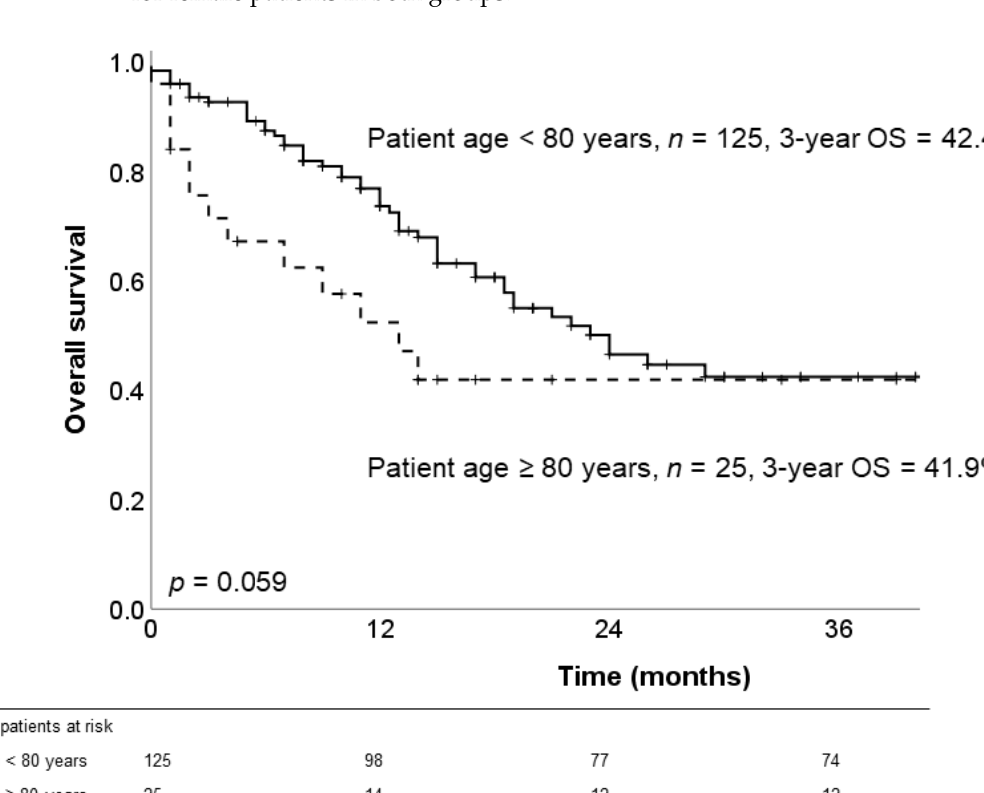
Figure 1. Comparison of overall survival (OS) in patients with pancreatic ductal adenocarcinoma ( n = 150) according to patient age (<80 years vs. ≥80 years).